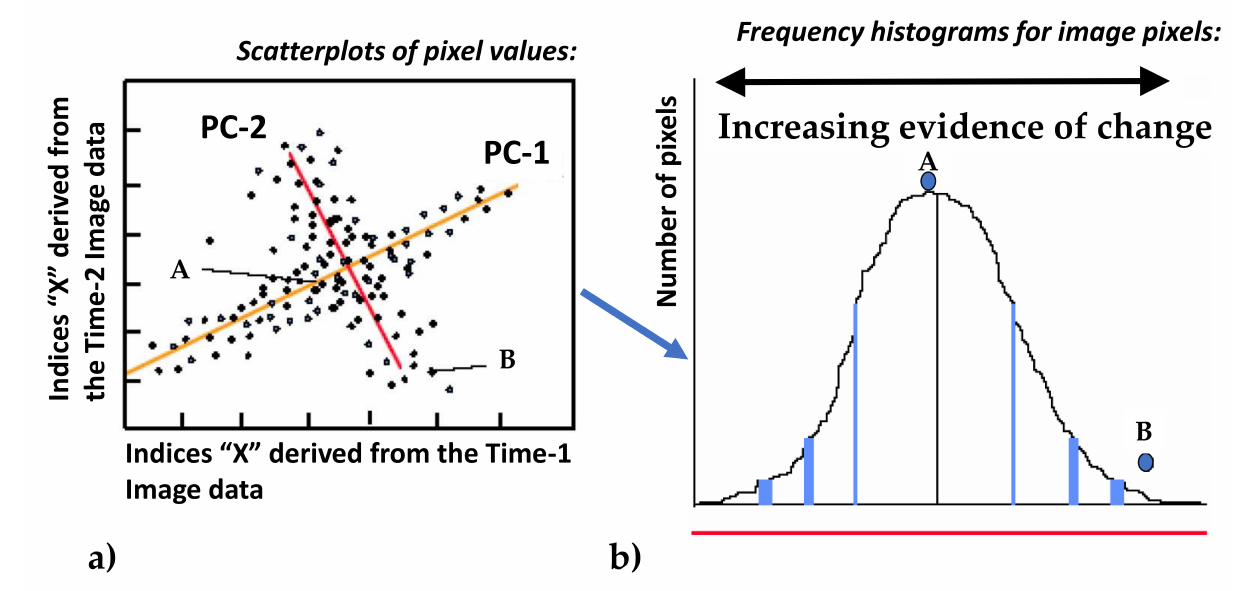
Figure 2. Principles of automatic change detection based on selective PCA. ( a ) Scatterplot of pixel values ( b ) Frequency histogram of image pixels (Source: